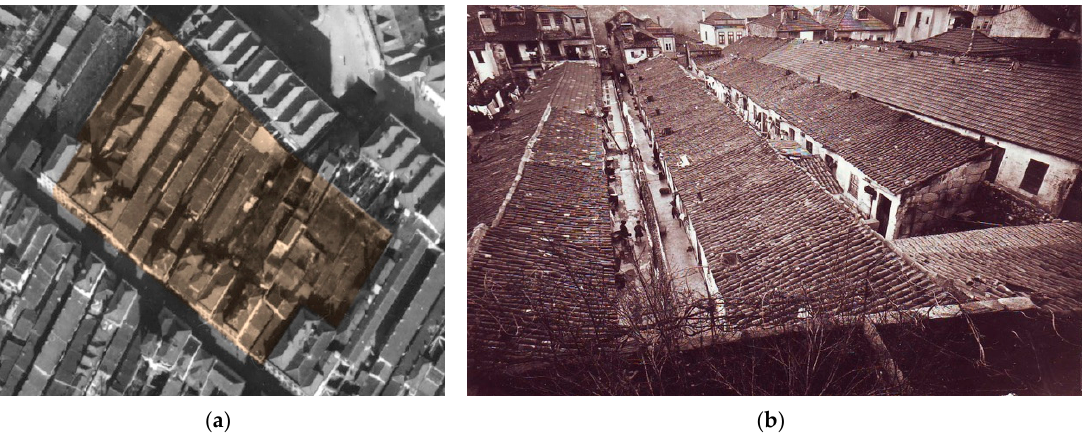
Figure 1. “Ilha” (slum island) of Sao Victor, Porto, Portugal: ( a ) aerial view, circa 1939; ( b ) Photographic survey by Joaquim Madureira, circa 1930.